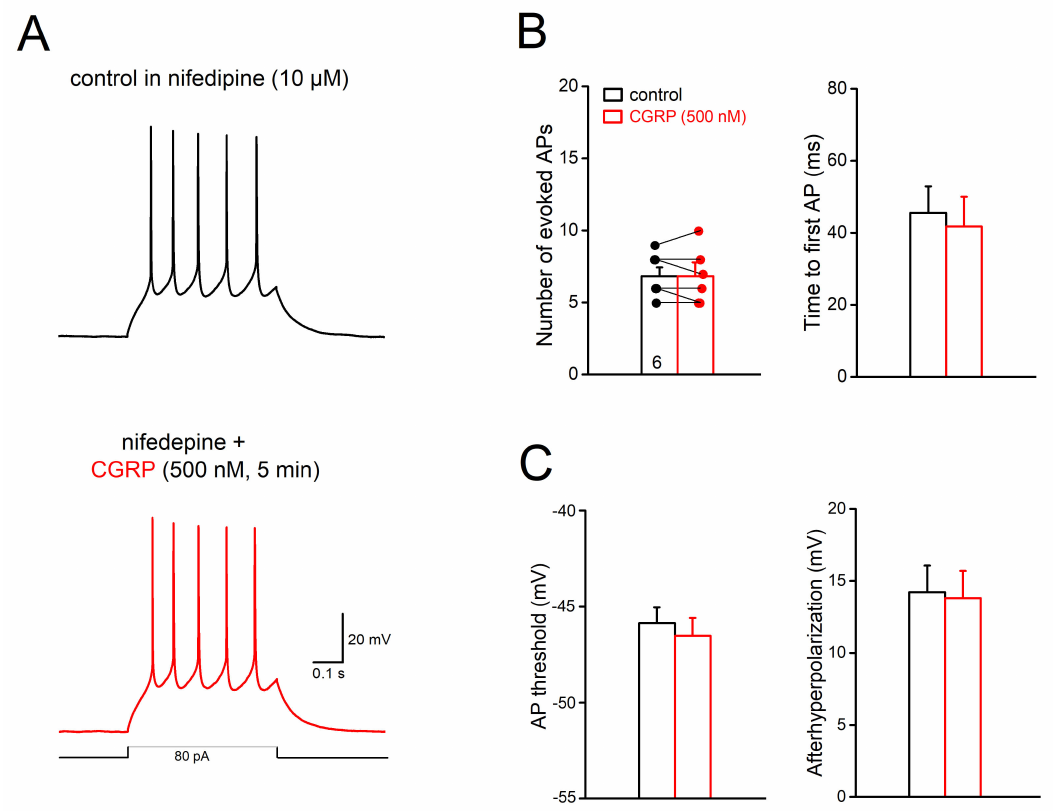
Figure 4. Involvement of L-type calcium channels in the excitatory effect of CGRP. All recordings were performed in the cocktail of KA, PTX and strychnine to block fast synaptic transmissions. ( A ) Voltage traces were collected from a Sp5C cell in laminae II before and during CGRP (500 nM) application, in the presence of the L-type calcium channel blocker nifedipine (10 µ M). ( B , C ) Histograms summarize that nifedipine blocks the responses of Sp5C cells to high concentration of CGRP (500 nM), manifested in AP discharges and time to evoke 1st AP ( B ), voltage threshold for AP and afterhyperpolarization ( C